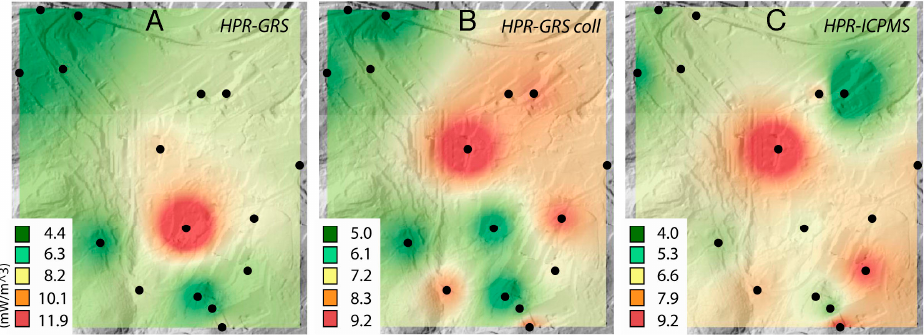
Figure 4. Interpolation maps obtained from the GIS with estimates of radiogenic heat production (RHP) obtained by ( A ) GRS, ( B ) GRS with a collimator, and ( C ) geochemical analyses (XRF + ICP-MS).